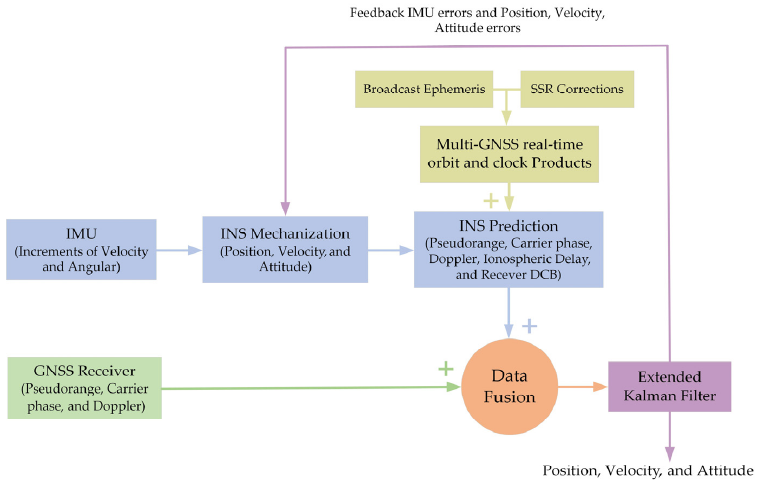
Figure 1. Implementation of real-time multi-GNSS SF-PPP/INS tight integration